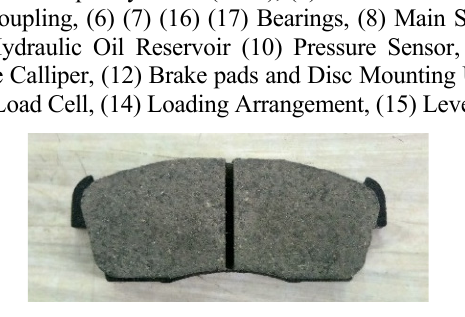
Figure 8. Friction brake pad (Brake Linear)